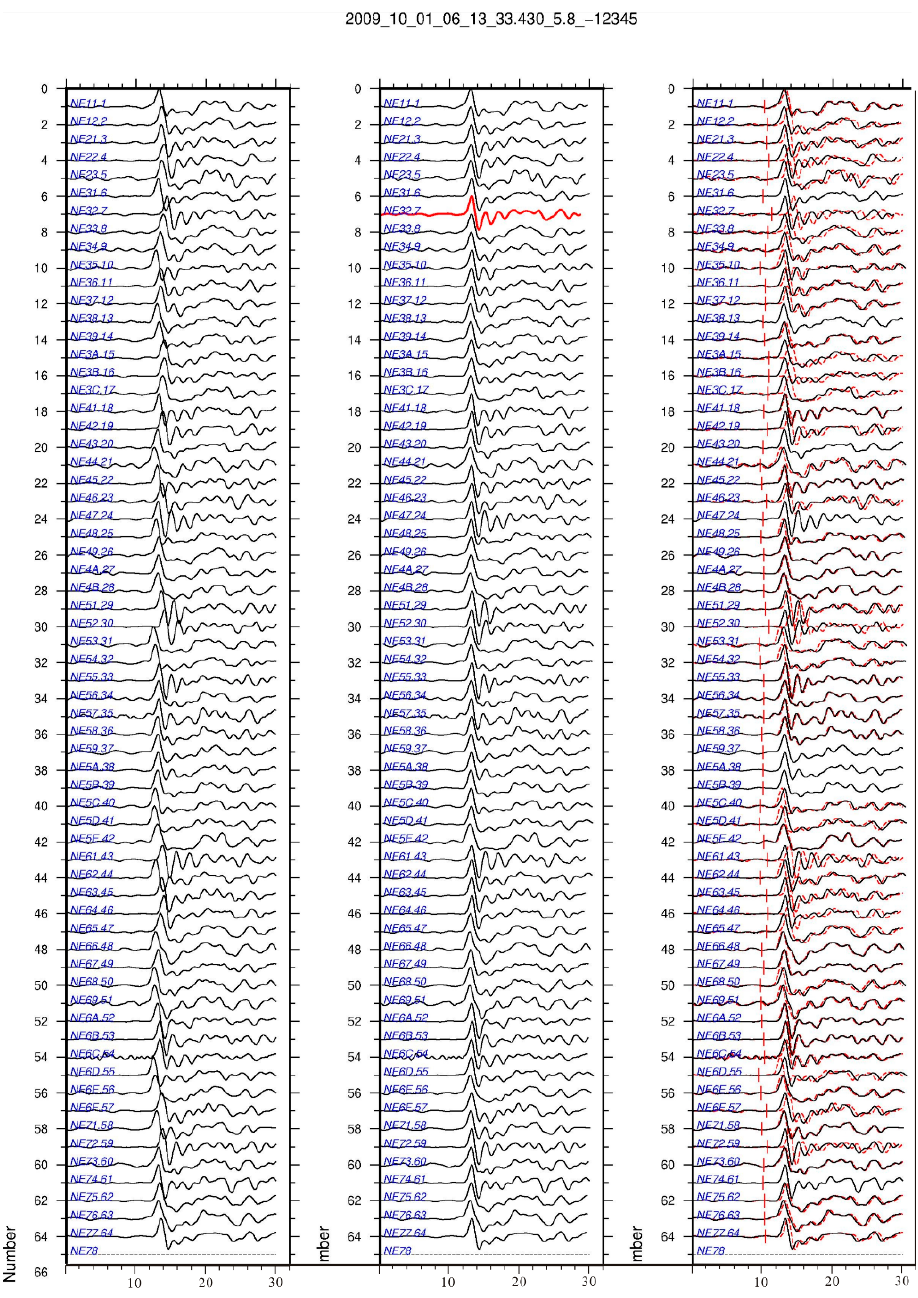
Figure 6. Schematic diagram of travel time residuals picked up by waveform cross-correlation in teleseismic. The left side is the original waveform arrangement, the middle side is the cross-correlation result, and the right side is the theoretical arrival time.